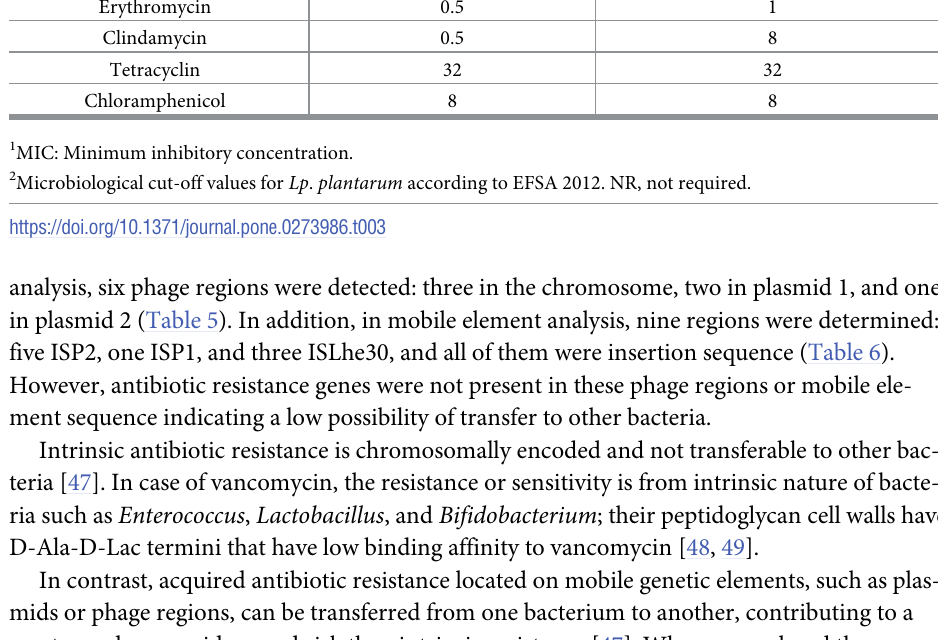
Table 4. List of antimicrobial resistance genes analyzed by BlastKoala and their locations in the genome of Lactiplantibacillus plantarum PMO 08.